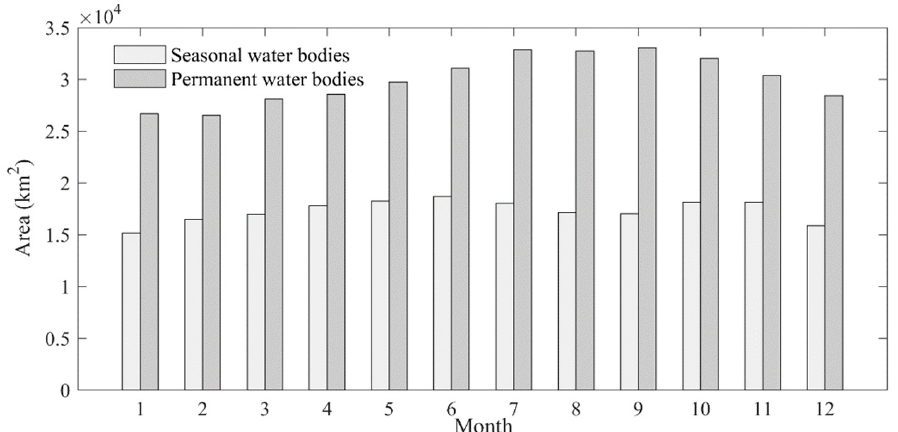
Figure 7. The monthly variation of surface water bodies for 1984 to 2018 in the YRB.